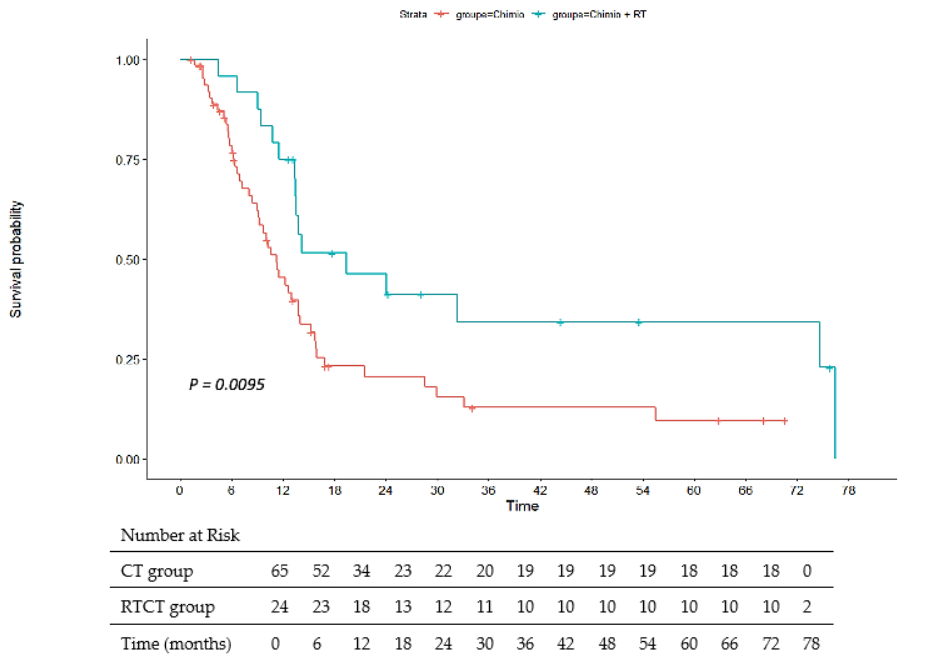
Figure 3. Progression-free survival. RT: radiochemotherapy; Chimio: chemotherapy.